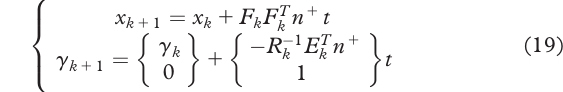
Algorithm Goldfarb-Idnani method (Goldfarb and Idnani, 1983; Horowitz and Afonso,